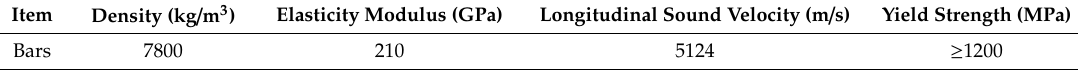
Figure 1. Schematic diagram of split Hopkinson pressure bar (SHPB) apparatus. Table 3. The properties of the